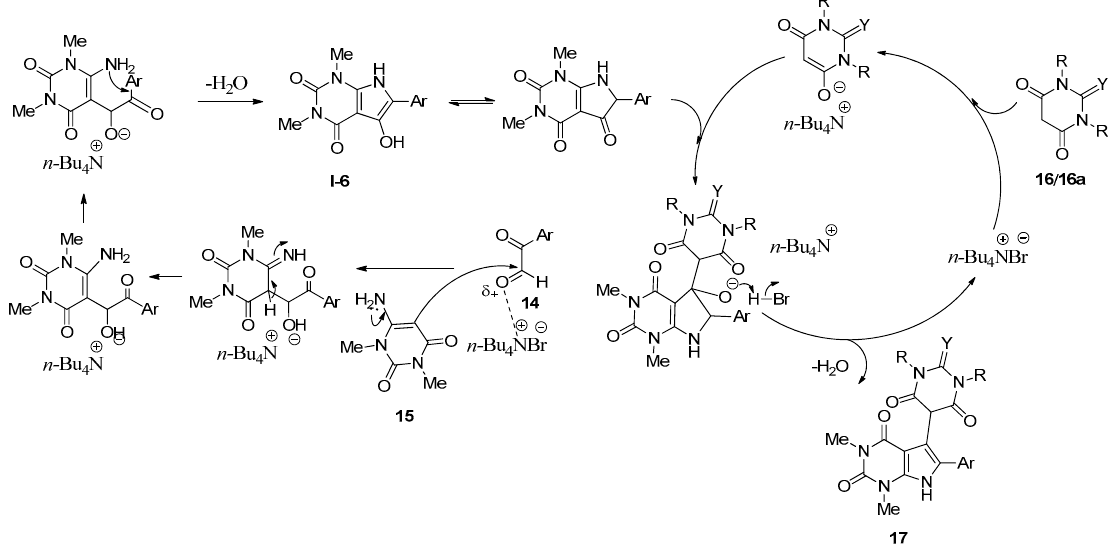
Scheme 8. Plausible mechanism of TBAB-catalyzed synthesis of pyrrolo[2,3- d ]pyrimidine derivatives.